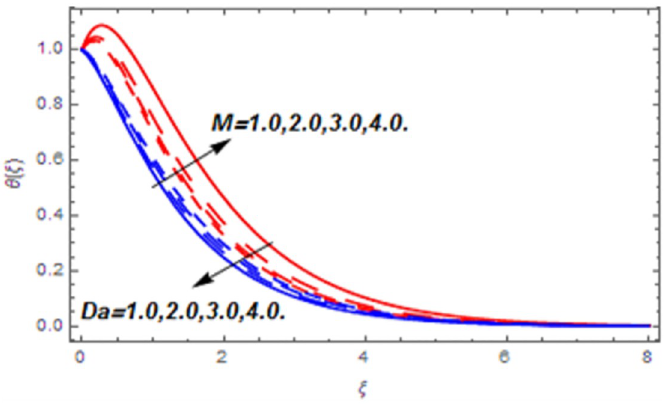
Fig 7. Thermal profiles versus Darcy number and magnetic